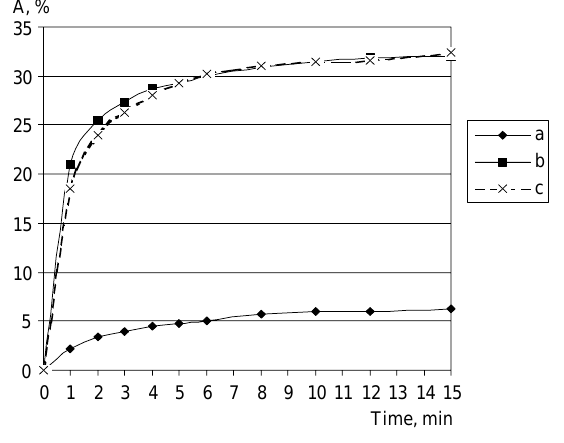
(c).05101520253035A, Fig. 10 Curves of leaching of the SHS product in the system Ni 40.8 wt.% Al (a), of the product of mechanical alloying in this system for 25 min. (b), of the SHS product after 1 min. activation